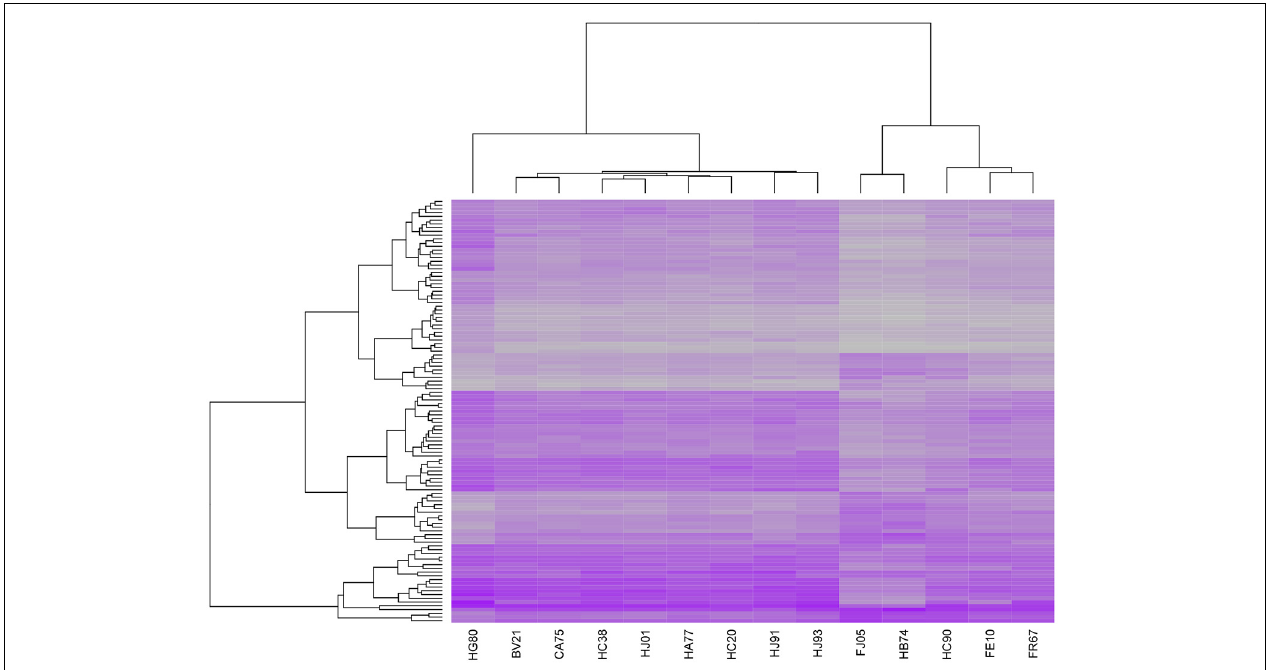
FIGURE 6 | Heatmap of expression profiles for 106 genes significantly associated with post-exposure time T and/or final severity score S and included in a set of 393 transcripts that were previously reported to effectively discriminate between cases